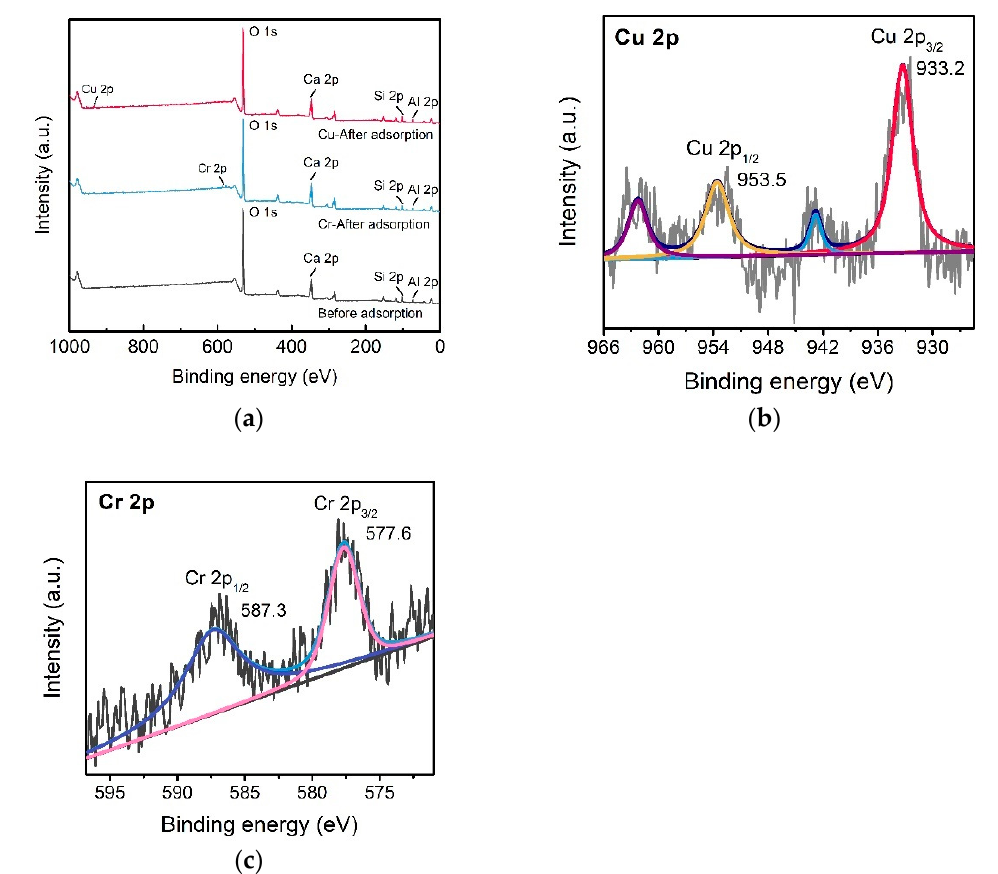
Figure 4. The XPS spectra of ( a ) C-S-H before and after adsorption, ( b ) Cu 2p of C-S-H after the reaction with Cu(II), and ( c ) Cr 2p of C-S-H after the reaction with Cr(VI).